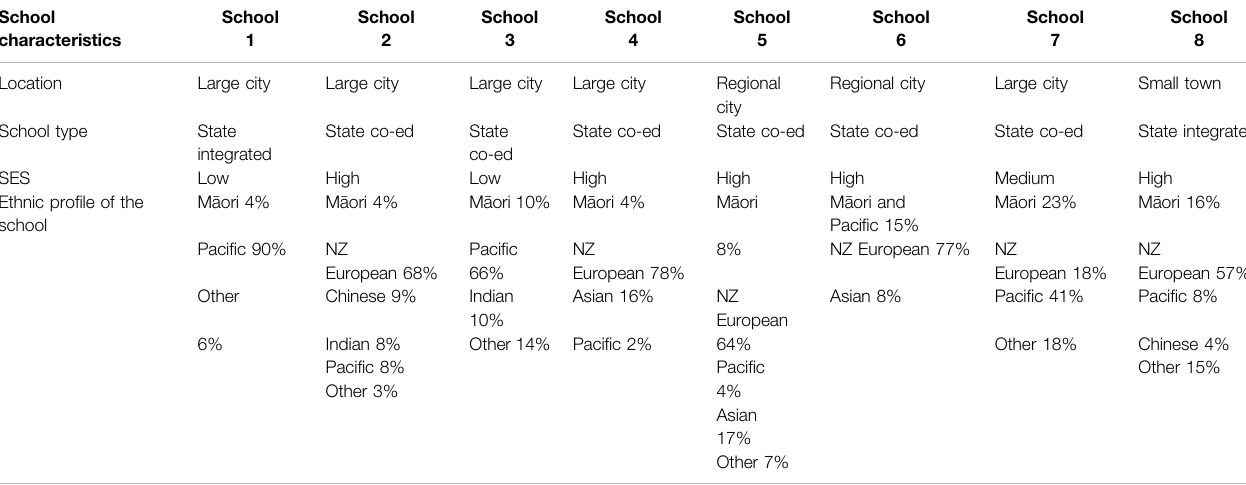
TABLE 1 | Characteristics of the